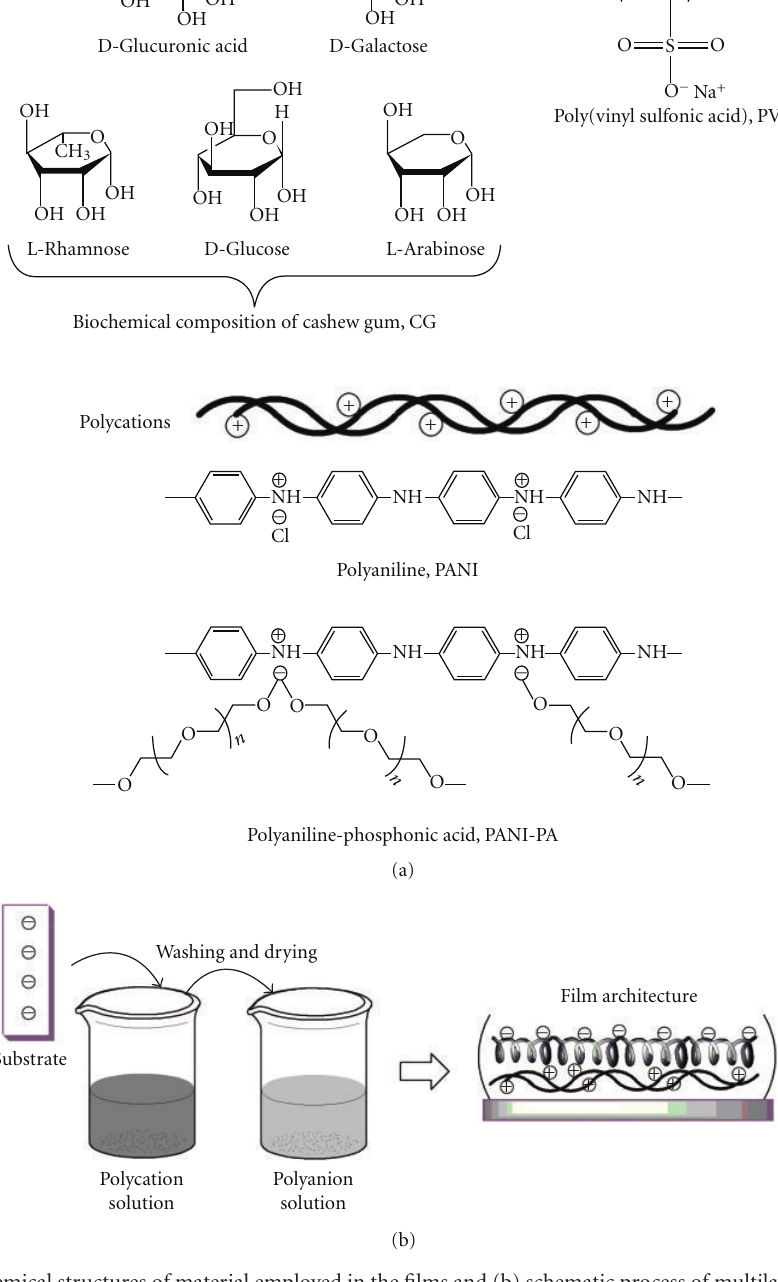
Scheme 1: (a) Chemical structures of material employed in the films and (b) schematic process of multilayer film